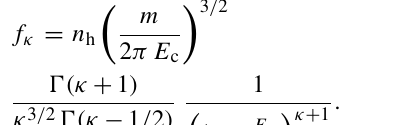
Fig. 4. The excitation cross sections σ d , σ ( 5 S ◦ ) and σ ( 5 P ) are plotted in Fig. 5.